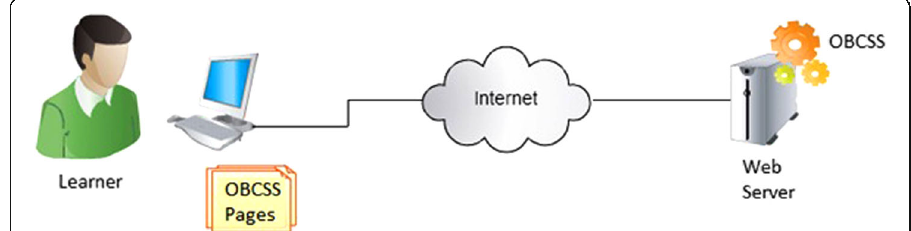
Fig. 4 General OBCSS